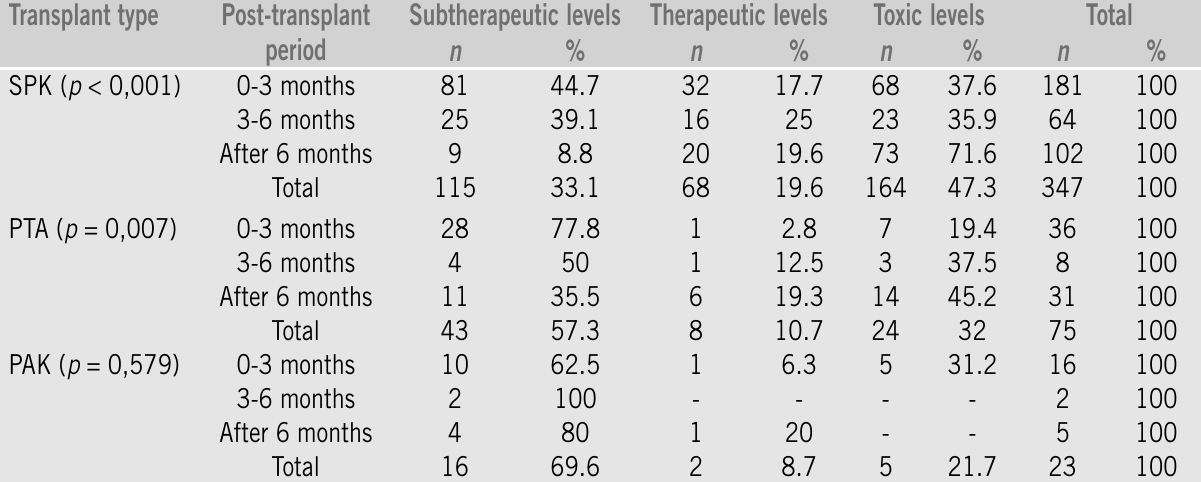
Analyses distribution associating blood levels, transplant type and post-transplant period Transplant type Post-transplant